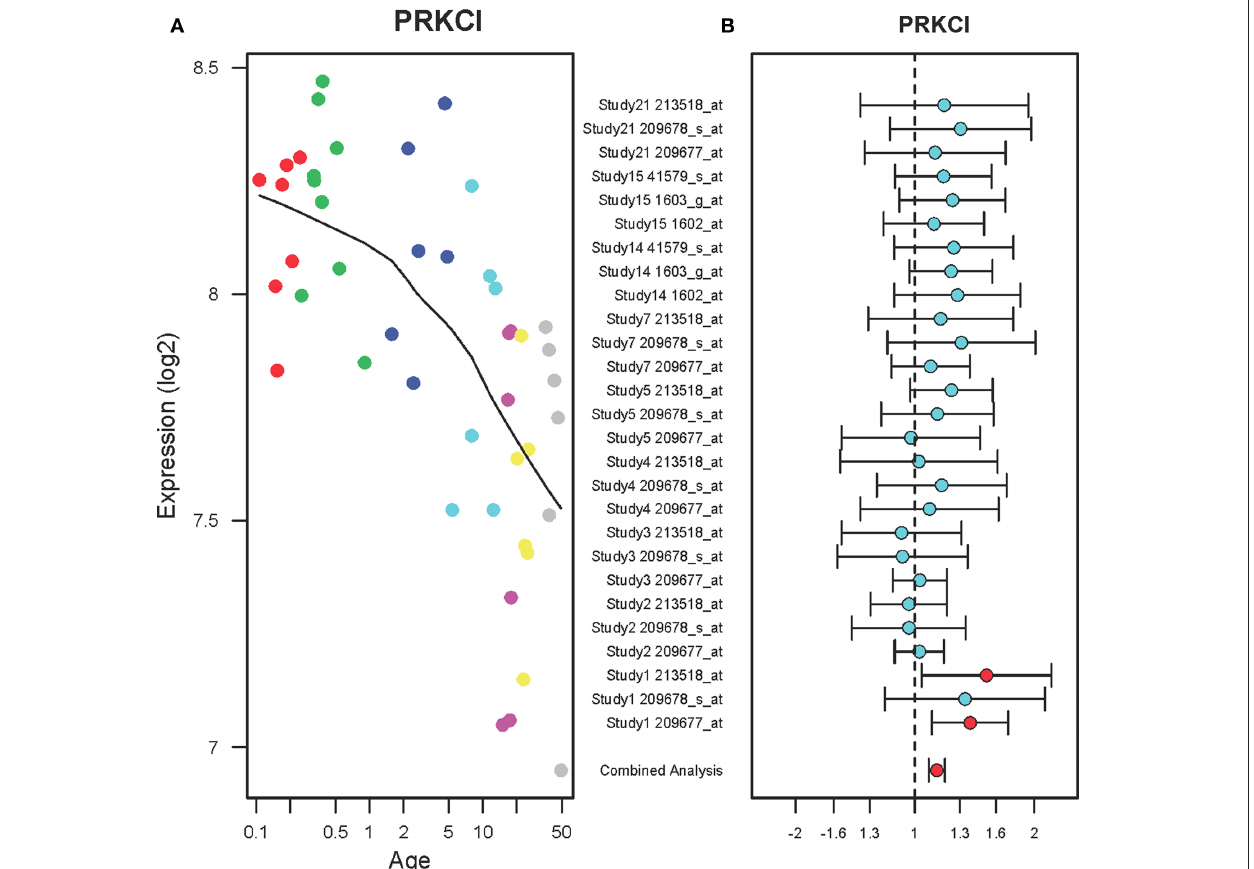
Figure 4 | The expression profiles PRKCI in the PFC of normal developing individuals and suicide victims. (A) The scatter plot with a locally weighted scatter plot smoothing (LOWESS) line demonstrates gradual decreases in expression of PRKCI in the PFC of normal humans ranging in age from birth to 49 years. Points are colored by the predefined age groups: red = neonate, green = infant, blue = toddler, light blue = school age, pink = teenage, yellow = young adult, gray: adult. (B) The plot with fold